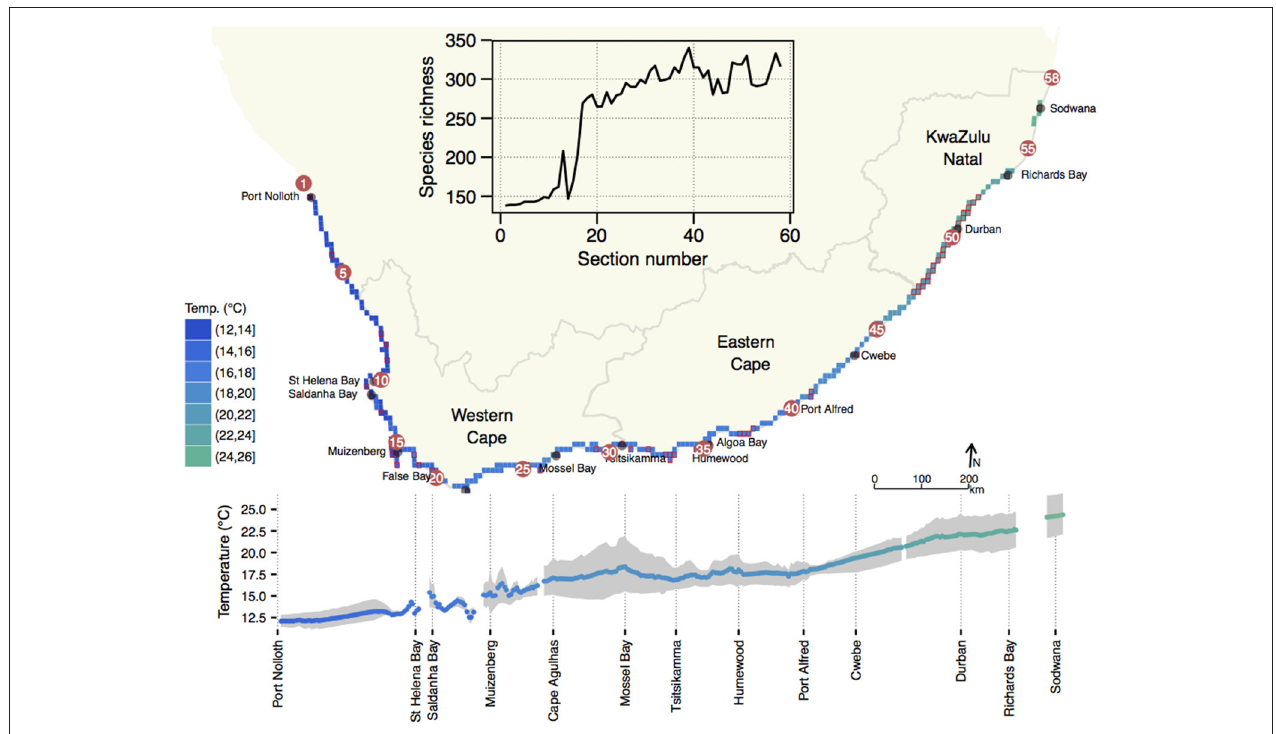
FIGURE 1 | Profile of mean annual temperature along the coast of South Africa. Profiles are indicated as a function of geographical position on a coastal map ( top ) and as a function of distance away from section 1 ( bottom ). The latter visualization also indicates the long-term minimum (mean August) and maximum (mean February) temperatures as a gray shaded area around the annual mean temperature. The inset shows the species richness of macroalgae along the coast. Note that although a detailed temperature profile is displayed here, further analyses in this paper proceed with temperature data interpolated to the 58 sections for which seaweed diversity data are